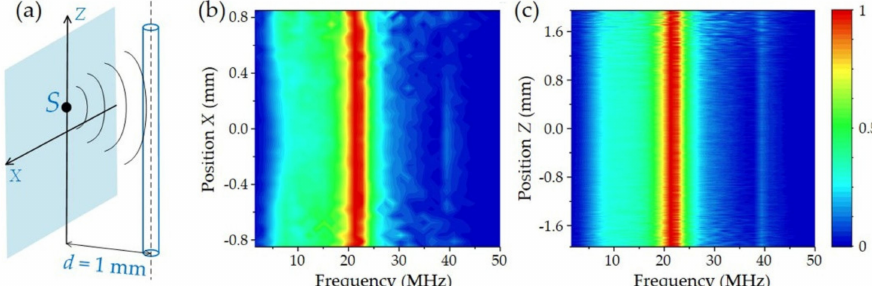
Figure 8. Measured frequency response of the fiber sensor. ( a ) Schematic of scanning acoustic source to measure the frequency response. ( b ) Measured frequency response with scanning source along the x axis ( c ) Measured frequency response with scanning source along the z axis. Figure adapted with permission from Ref.